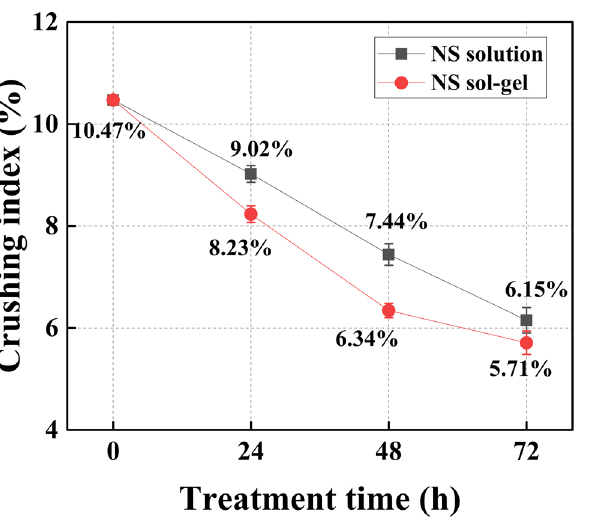
Figure 9: E ff ect of treatment time on the crushing index of RCA.